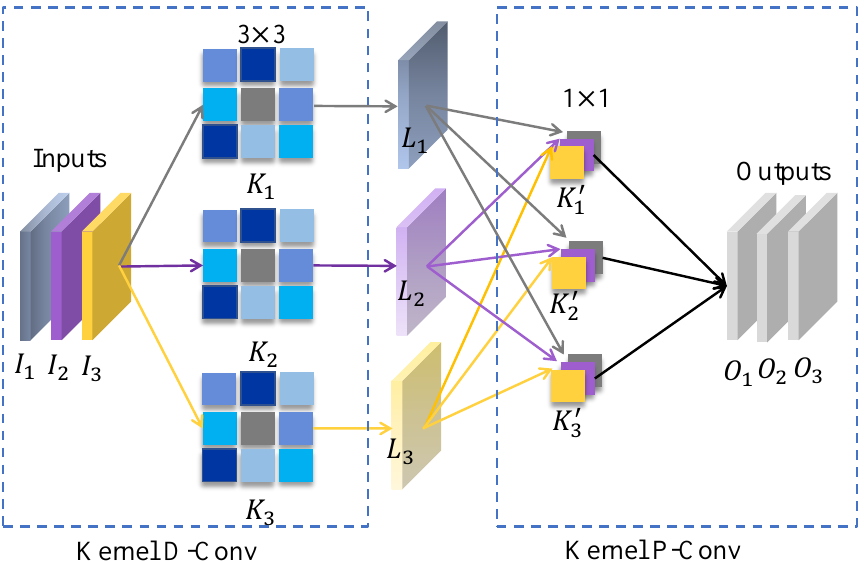
Figure 2. Depthwise separable convolution architecture, where I 1 , I 2 , I 3 represent inputs, K 1 , K 2 , K 3 , and K 1 (cid:48) , K 2 (cid:48) , K 3 (cid:48) represent convolution kernels, L 1 , L 2 , L 3 represent intermediate layer outputs, O 1 , O 2 , O 3 represent